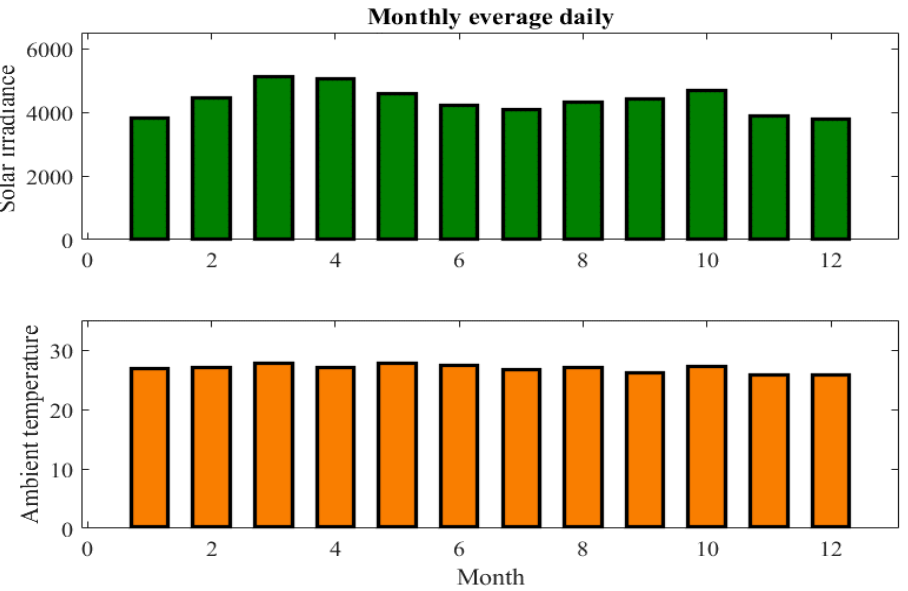
Figure 7. Monthly average of meteorological data in Malaysia.